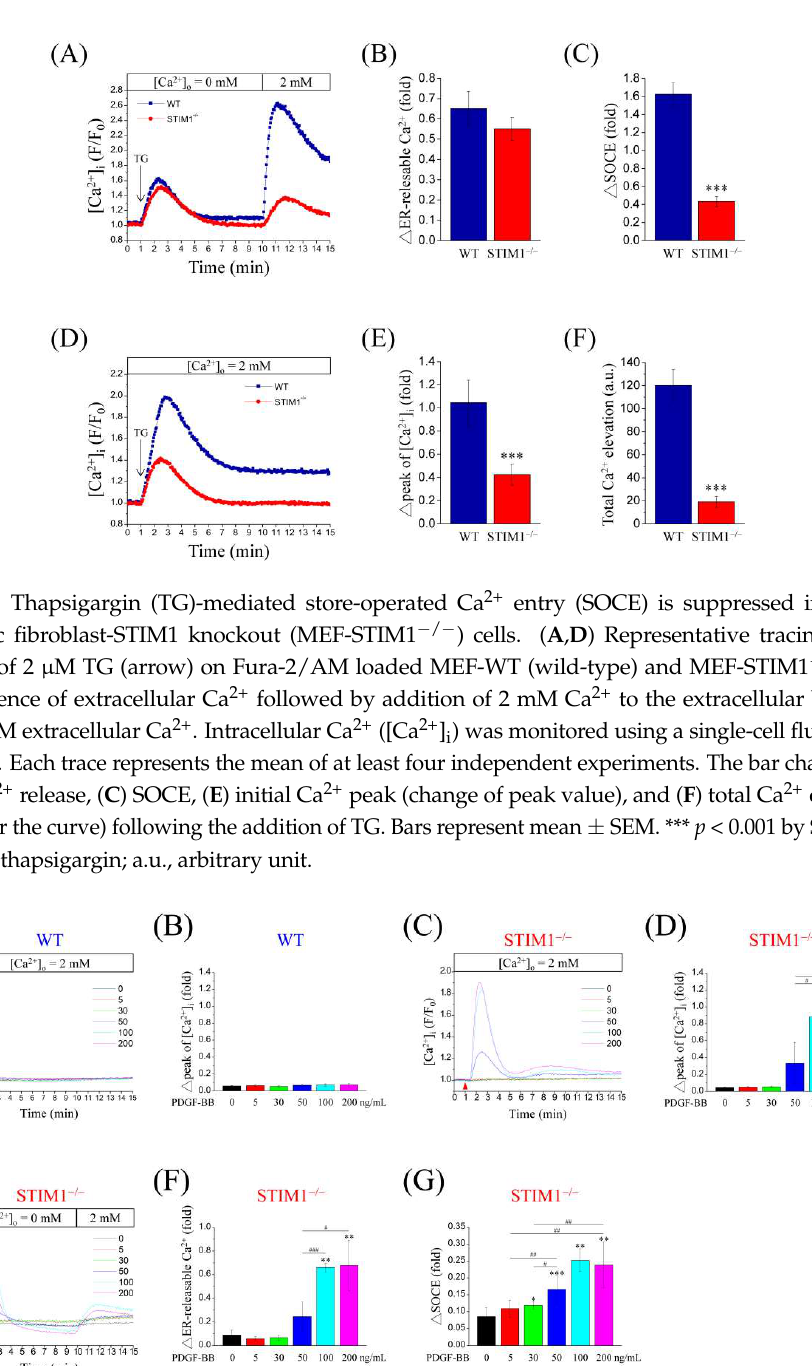
Figure 2. PDGF-BB induces Ca 2+ elevation in MEF-STIM1 −/− cells but not in MEF-WT cells. Representative tracings showing the effect of PDGF-BB (0–200 ng/mL, arrowhead) in Fura-2/AM-loaded, serum-starved ( A ) MEF-WT, ( C ) MEF-STIM1 −/− cells at 2 mM extracellular Ca 2+ , and ( E ) MEF-STIM1 −/− cells in the absence of extracellular Ca 2+ followed by addition of 2 mM Ca 2+ to the extracellular buffer. Intracellular Ca 2+ ([Ca 2+ ] i ) was monitored using a single-cell fluorimeter for 15 min. ( B , D , F , G ) Bar charts indicate ( B ) initial Ca 2+ peak of MEF-WT and ( D ) initial Ca 2+ peak, ( F ) ER Ca 2+ release, and ( G ) SOCE of MEF-STIM1 −/− cells following the addition of PDGF-BB. Bars represent mean ± SEM. *,#: p < 0.05; **,##: p < 0.01; ***,###: p < 0.001 by one-way ANOVA with Dunnett’s post-hoc test.